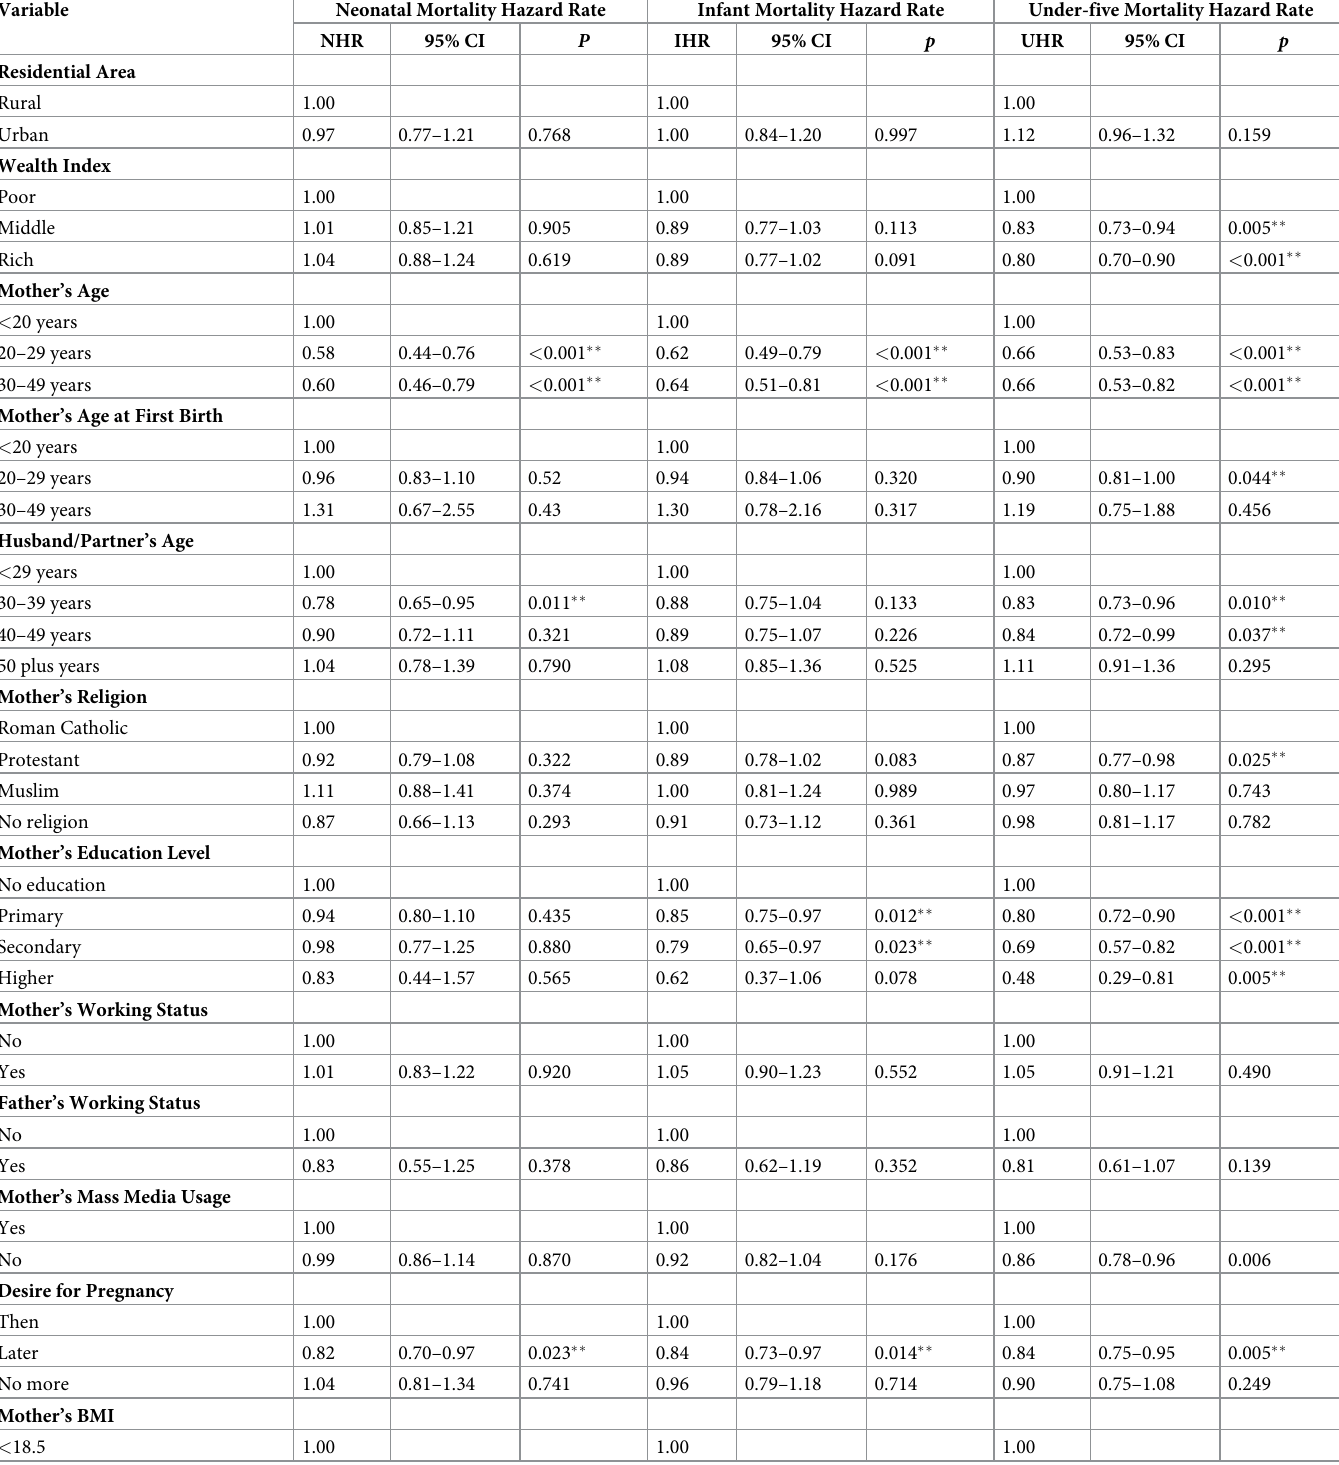
Table 5. Univariate analysis of the association between neonatal, infant, and under-five mortality in East Africa and sociodemographic and behavioral